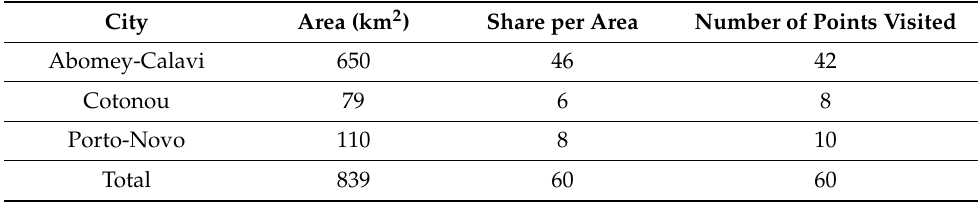
Table 2. Share of visited points per